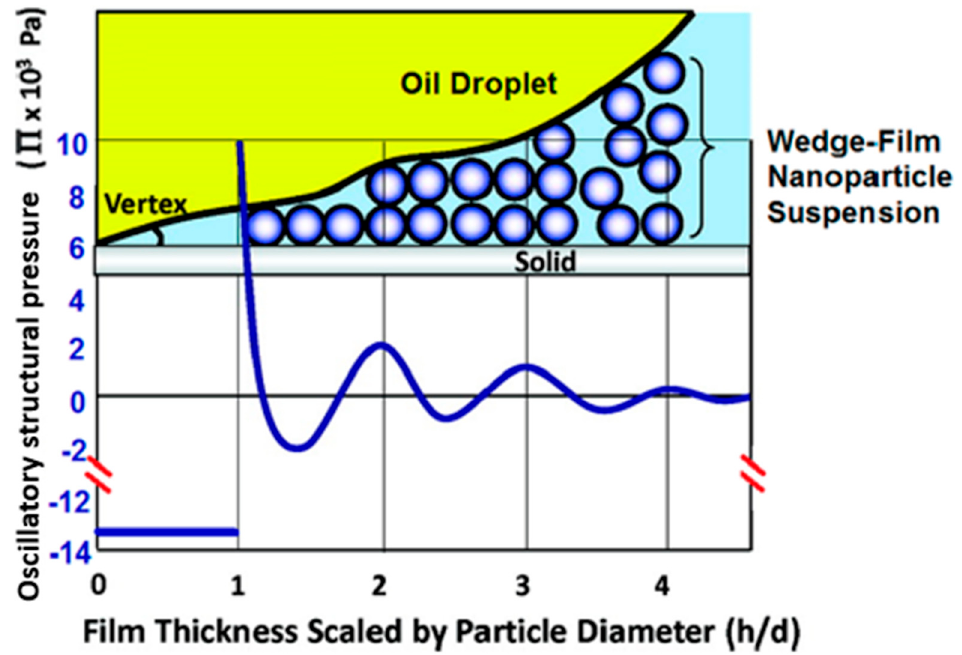
Figure 1. Layering of the particles in the wedge film, and the distribution of the oscillatory structural pressure as a function of the radial distance scaled by the particle diameter. Adapted with permission from [8]. Copyright 2014 American Chemical Society.